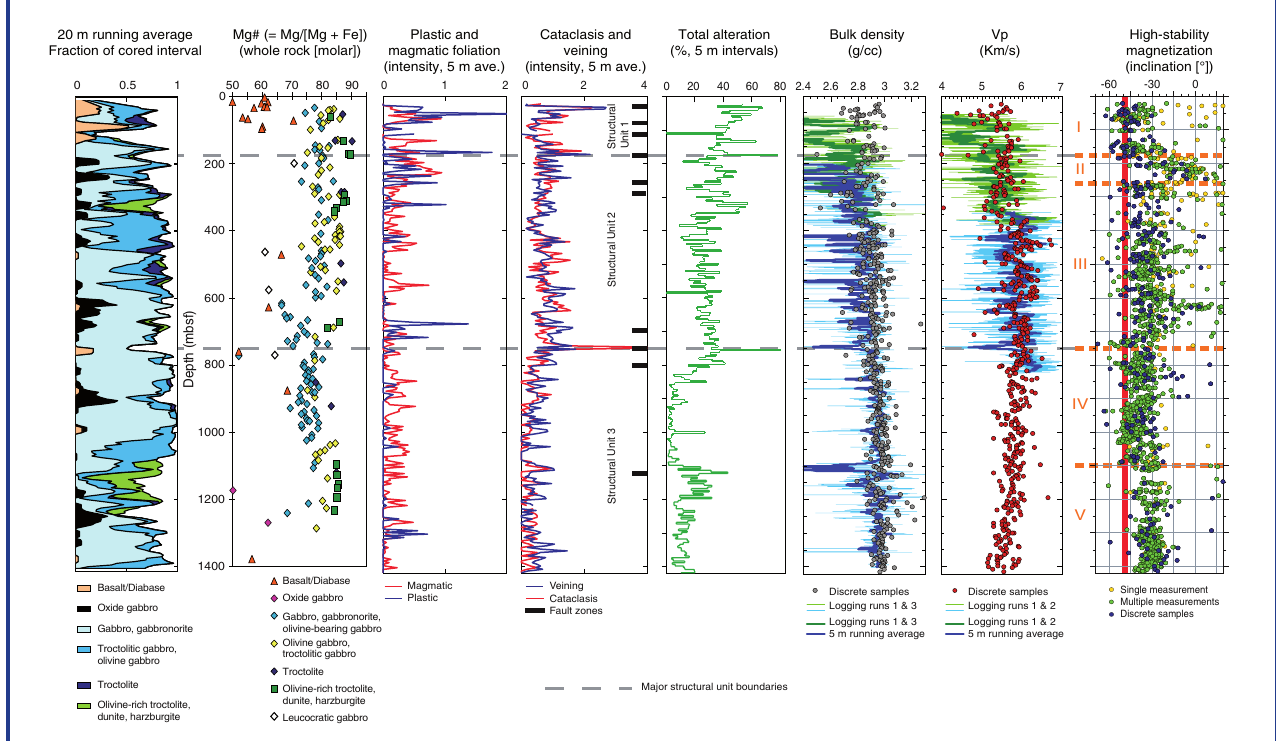
Figure 2. Downhole plots (Hole U1309D) of (left to right): lithology (20 m running average, white = no recovery), Mg#, plastic and magmatic foliation intensity (macroscopic description), cataclasis and veining intensity (macroscopic description), total alteration (macroscopic description), bulk density (from borehole and discrete sample measurements), compressional velocity (from borehole and discrete sample measurements), and inclination of stable remanent